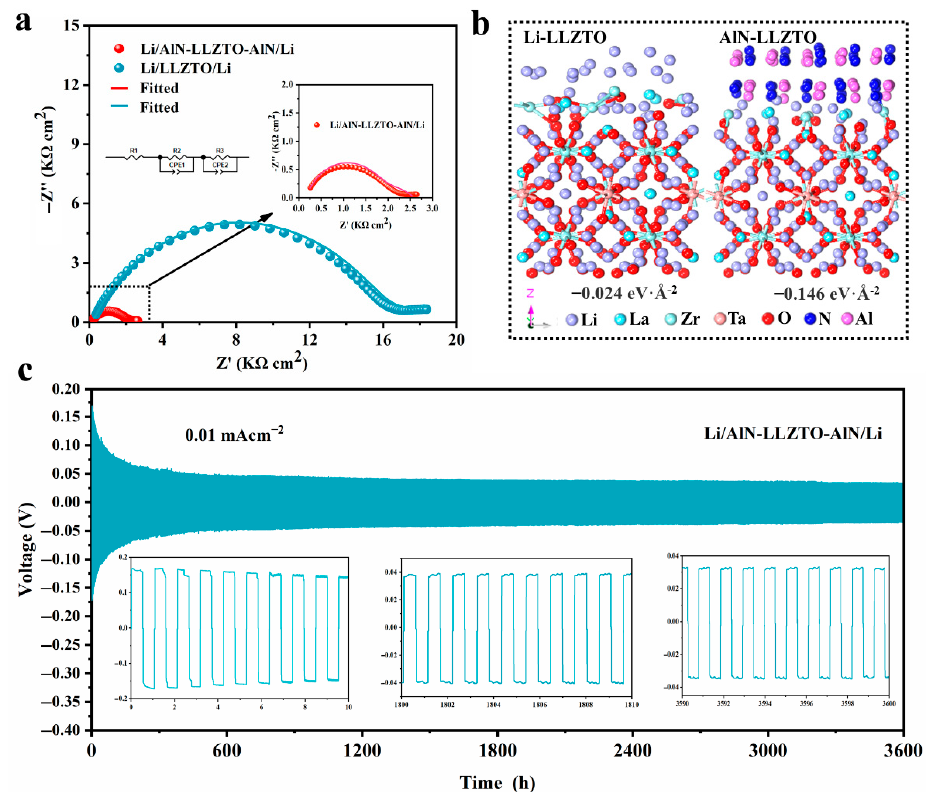
Figure 4. ( a ) Comparison of Nyquist plots of Li/AlN-LLZTO-AlN/Li and Li/LLZTO/Li at 30 °C; ( b ) DFT calculations of the interface formation energies for Li/LLZTO and AlN/LLZTO; ( c ) voltage profiles and details for the symmetric (Li/AlN-LLZTO-AlN/Li) cell for current densities of 0.01 mA cm − 2 with 0.005 mAh cm − 2 .